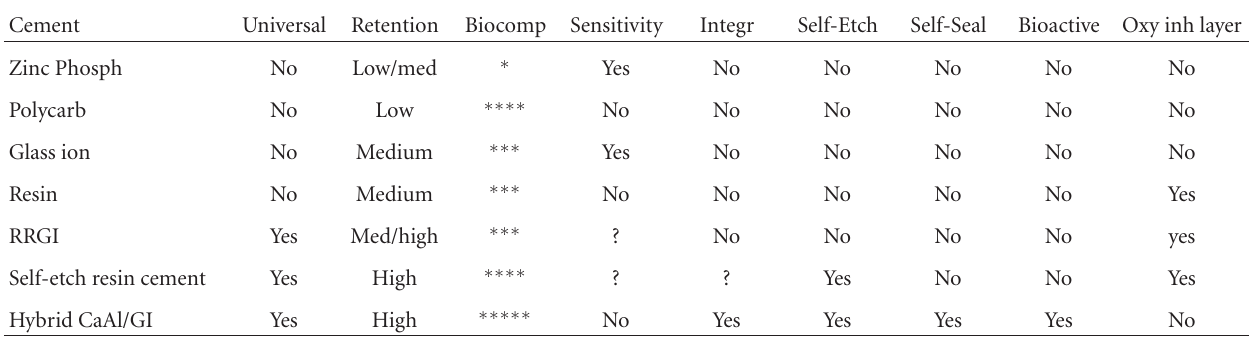
Table 1: This Table compares properties of the various generic cements. (Biocomp: biocompatibility; Integr: integration, Oxy inh layer: oxygen inhibited layer, RRGI: resin reinforced glass ionomer).